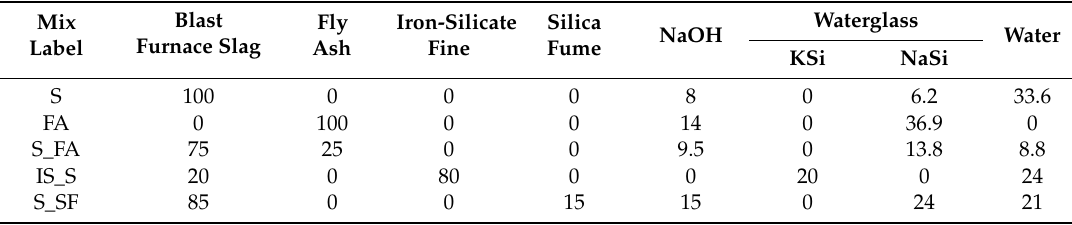
Table 2. Mix design of the mortars developed in this